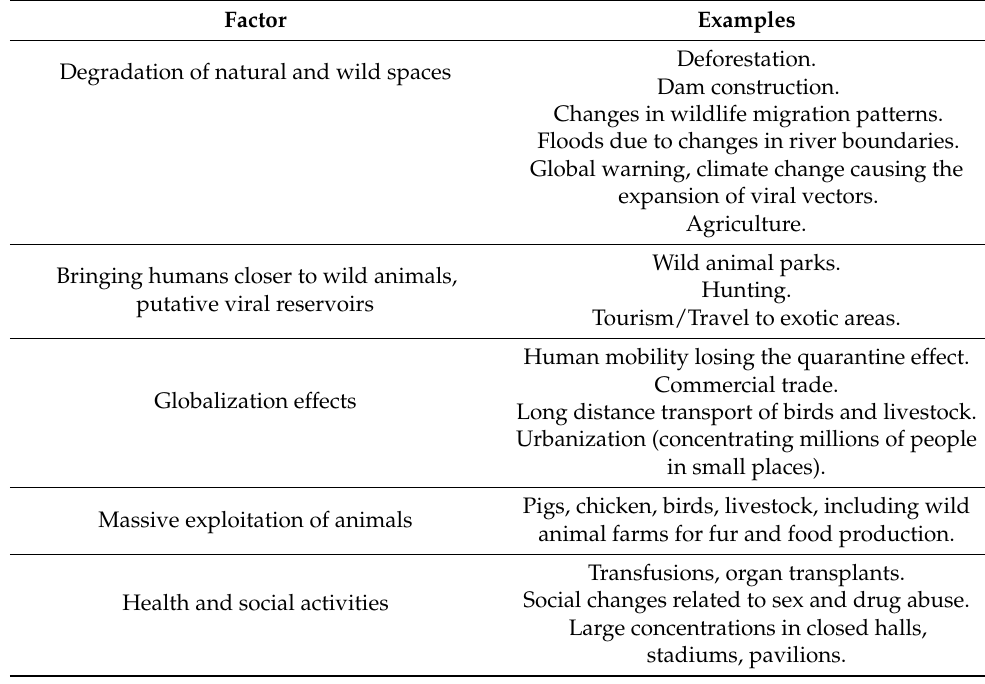
Table 1. Summary of factors related to a higher probability of